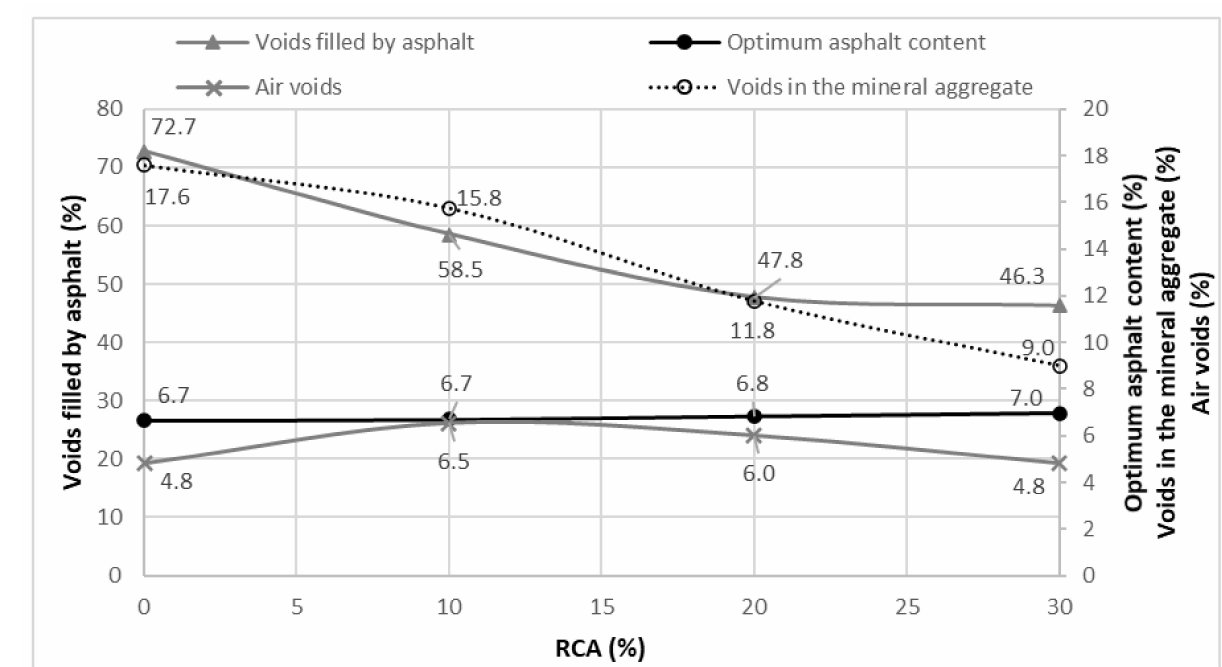
Figure 15. Correlation of VFA versus optimum asphalt content, VMA and air voids.